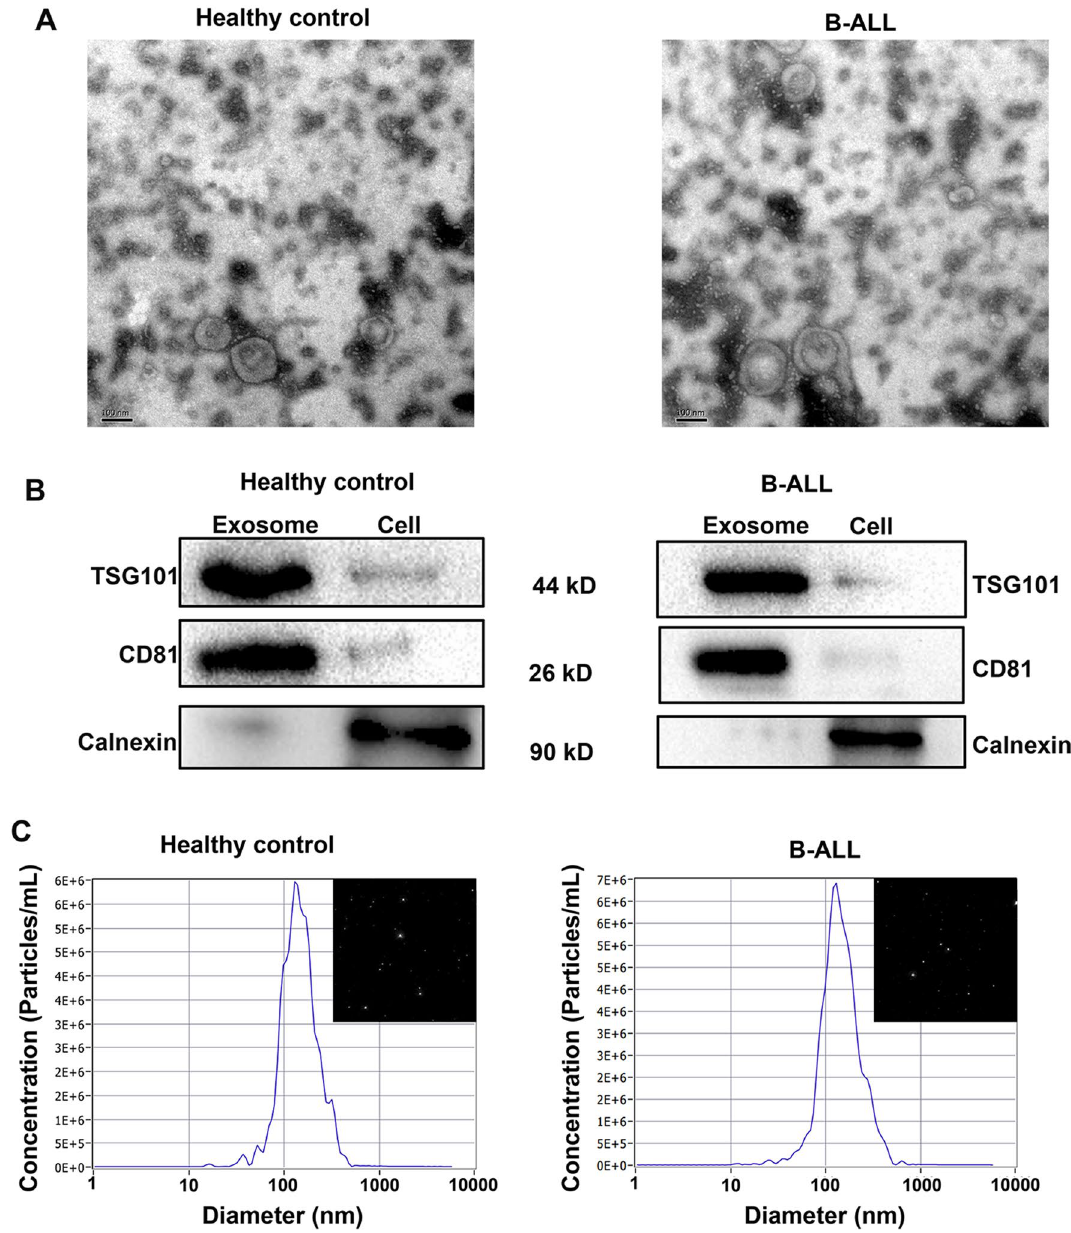
Figure 2. Plasma exosome characterization. ( A ) Representative morphology of the exosomes by transmission electron microscopy. ( B ) Detection of specific surface markers in the isolated exosomes by western blot. ( C ) The size of the isolated exosomes was determined by nanoparticle tracking